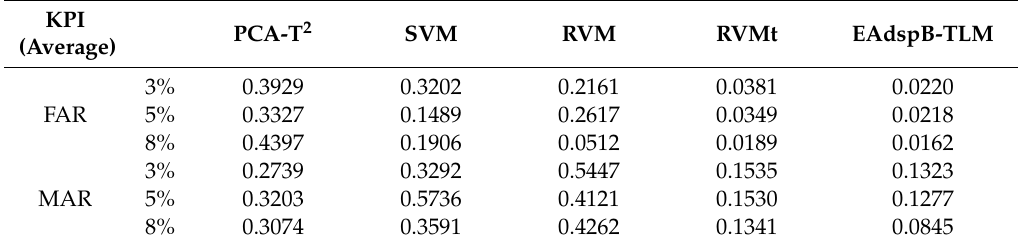
Table 4. Average of false alarm rate (FAR) and missed alarm rate